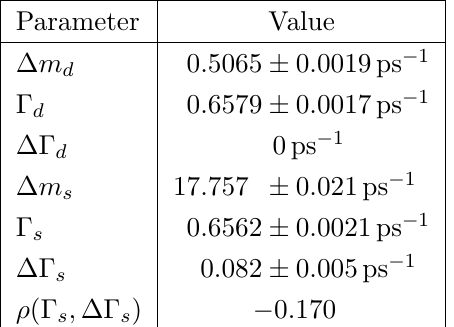
Table 1 . Values of the parameters (cid:1) m d , (cid:1) m s , (cid:0) d [25], (cid:0) s and (cid:1)(cid:0) s [60] used in the two methods. For (cid:0) s and (cid:1)(cid:0) s the correlation factor, (cid:26) , between the two quantities is also reported. The decay width di(cid:11)erence (cid:1)(cid:0) d is (cid:12)xed to zero.